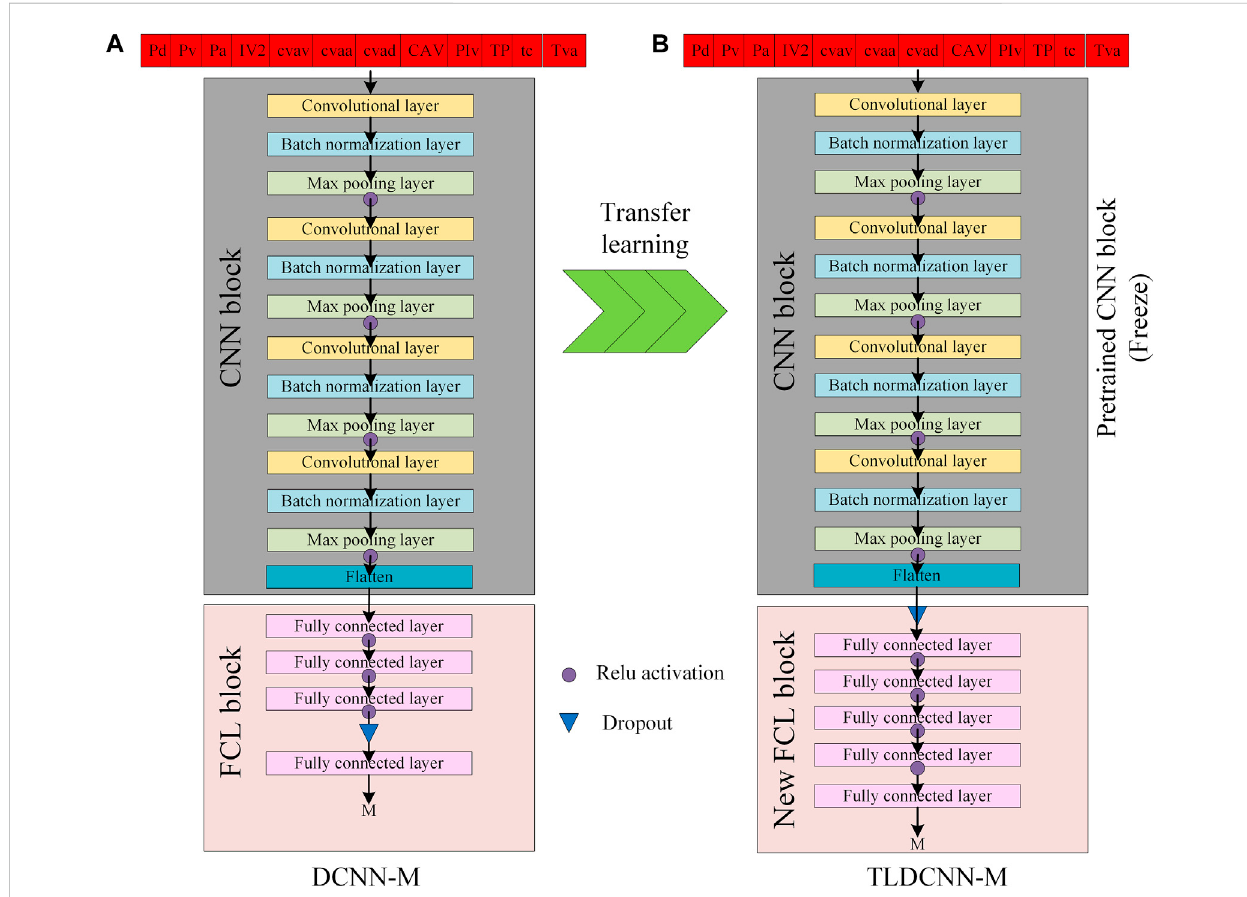
FIGURE 3 The framework of (A) the DCNN-M model [20] and (B) the TLDCNN-M model. The DCNN-M model is composedof a CNN block and an FCL block. The TLDCNN-M model is composed of a pretrained CNN block and a new FCL